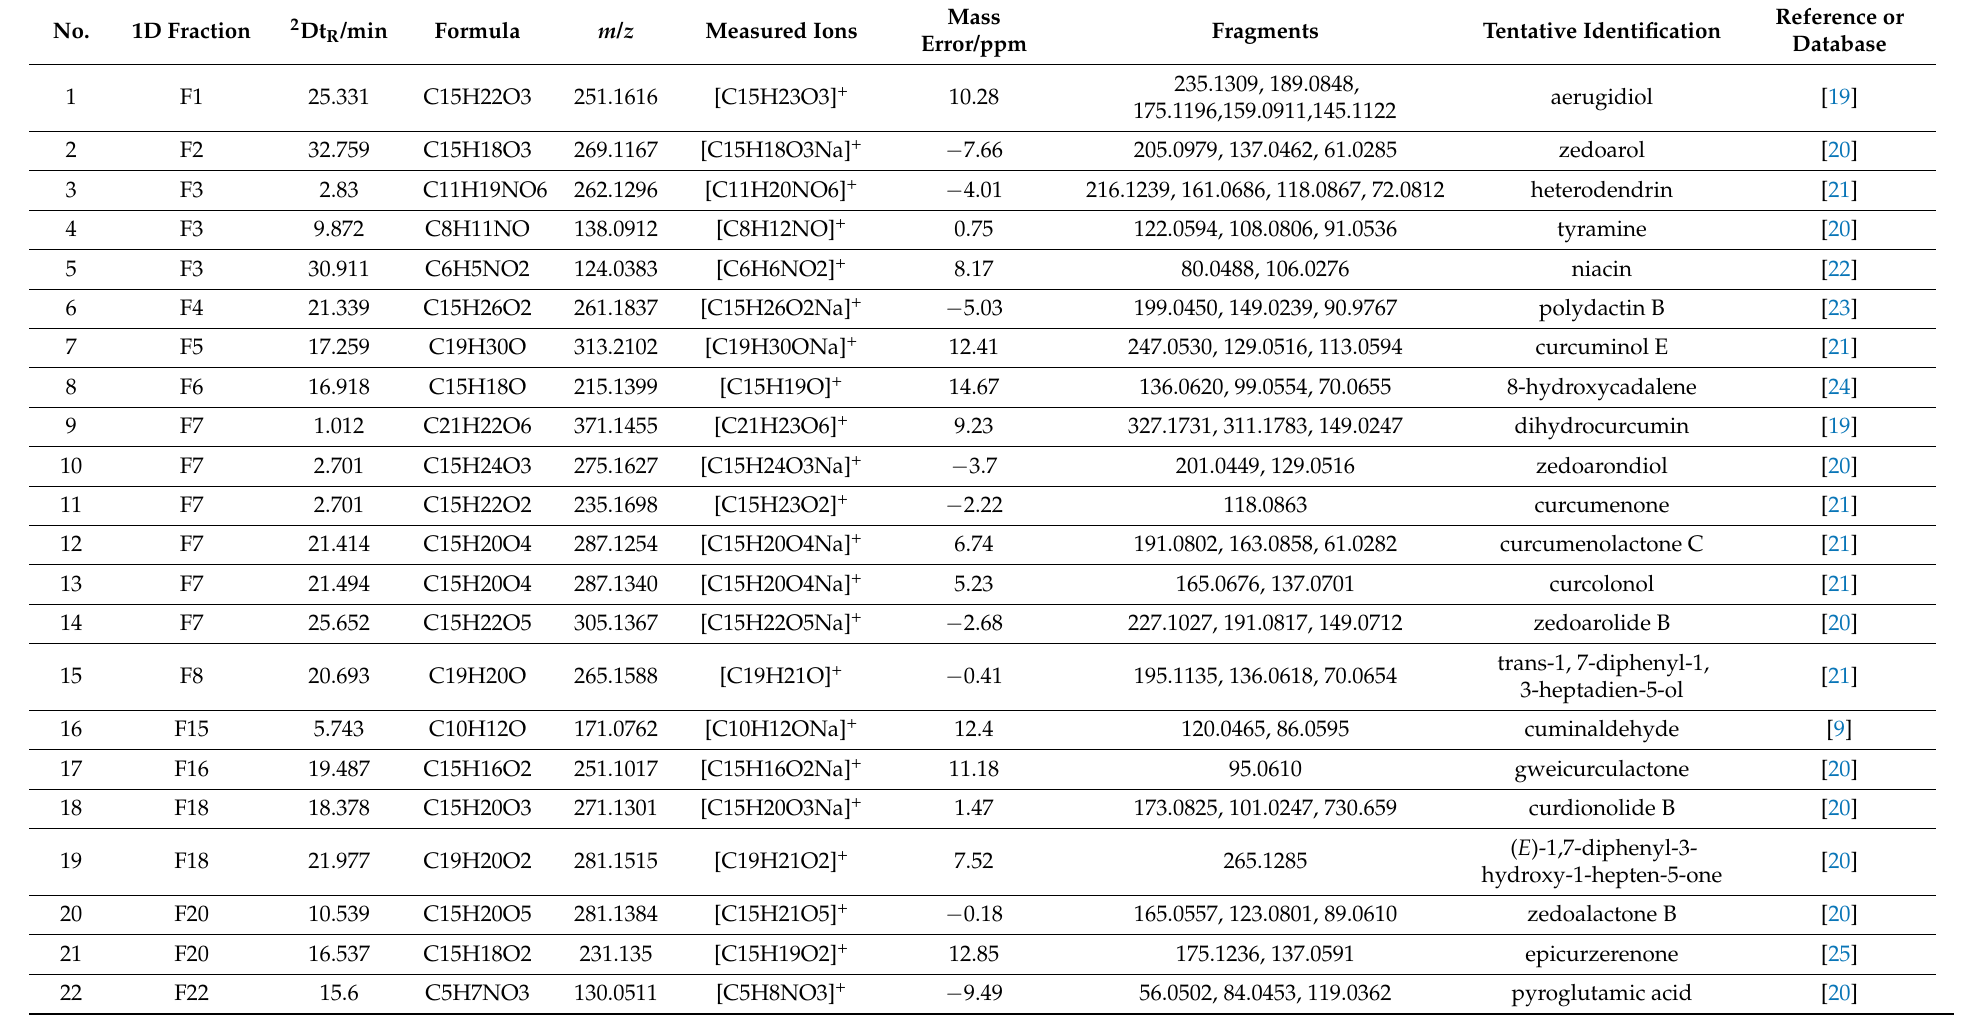
Table 1. Tentatively identified chemical constituents of C. Kwangsinesis by comprehensive 2D LC-Q-TOF